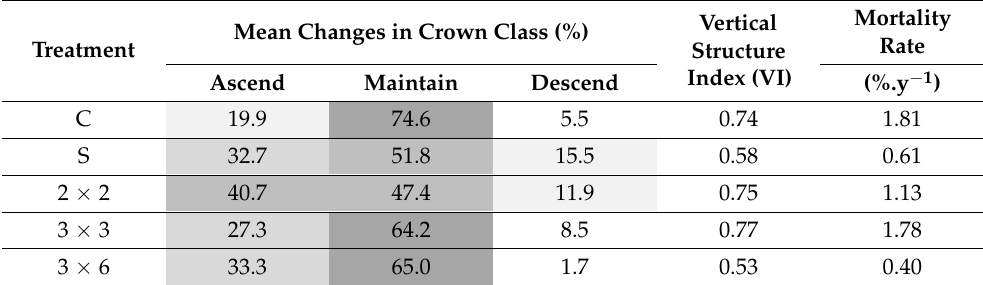
Table 4. The dynamic of the tree crown class, vertical structure index, and mortality rate for the different cutting methods in Pyrenean oak coppice.